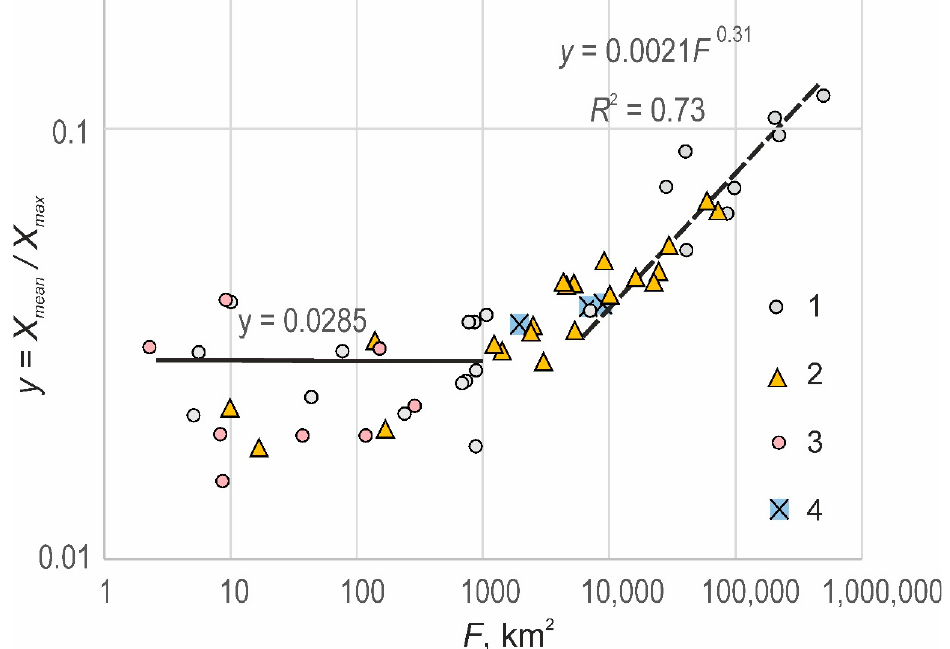
Figure 14. The relationship between the ratio of mean annual and mean maximum runoff depths y and contributing basin area F for the rivers of Vilyui River basin (1), of the northeastern European Russia (2), of the Yamal Peninsula [34] (3) and for the ancient rivers of the East European Plain [35]